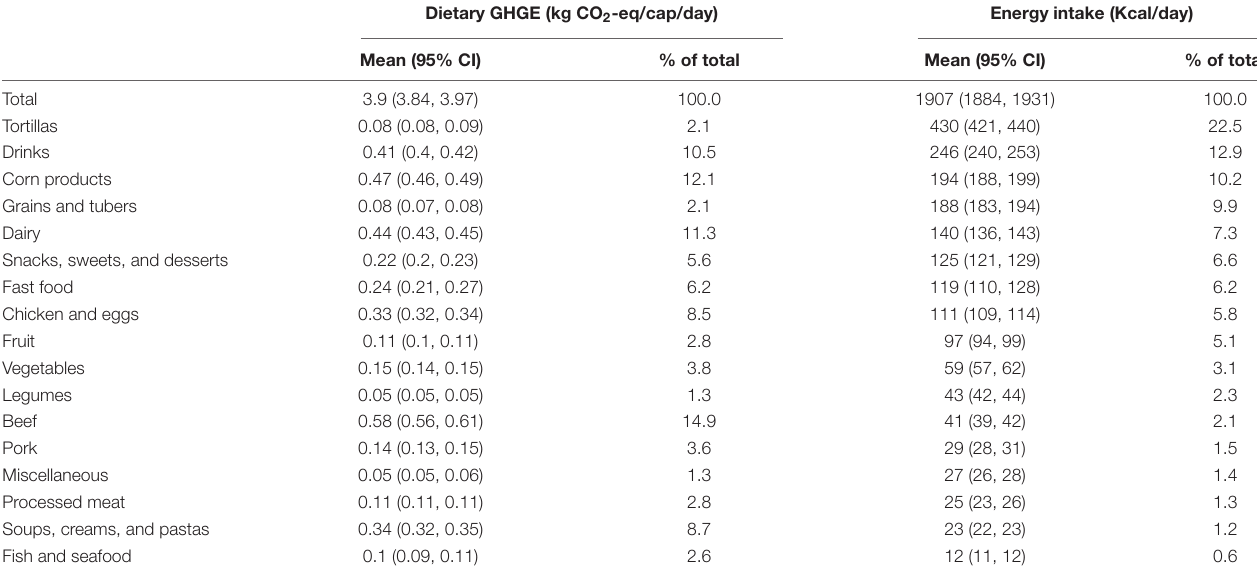
TABLE 1 | Dietary greenhouse gas emissions and energy intake per day by food group among the Mexican population. Dietary GHGE (kg CO 2